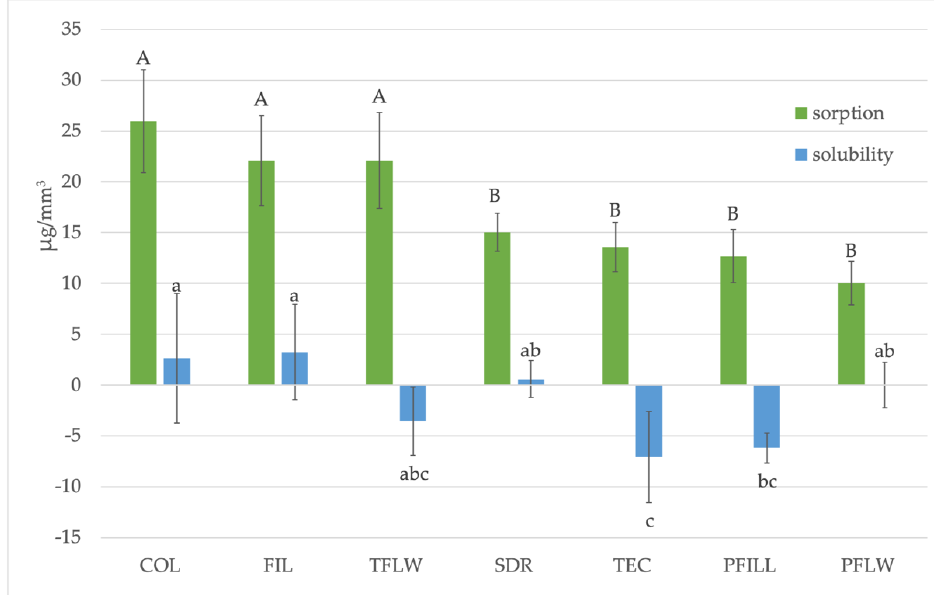
Figure 6. Comparison of water sorption and solubility of tested materials. Uppercase letters indicate statistically similar sorption values, while lowercase letters indicate statistically similar solubility values ( p < 0.05).